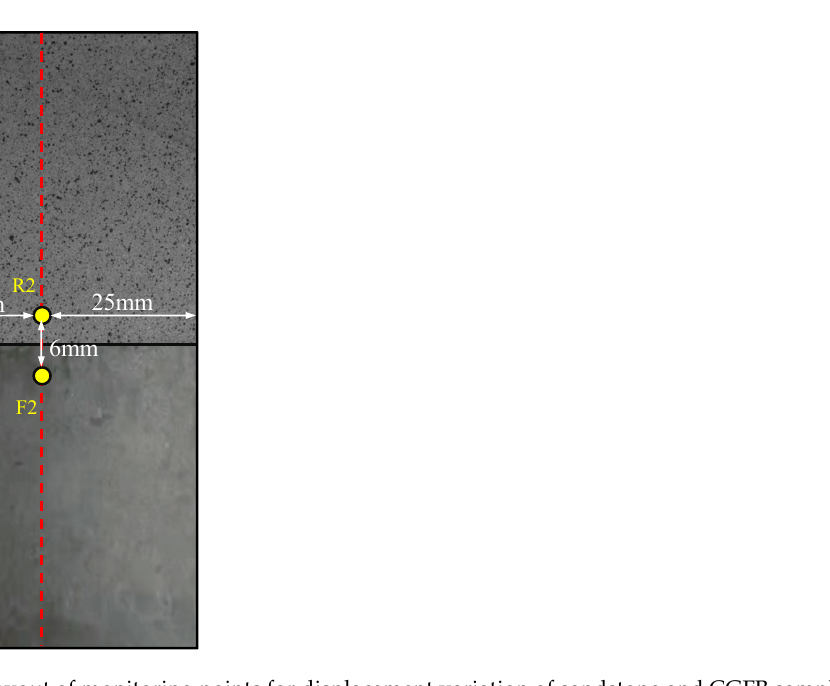
Figure 11. Layout of monitoring points for displacement variation of sandstone and CGFB samples near the intersection.